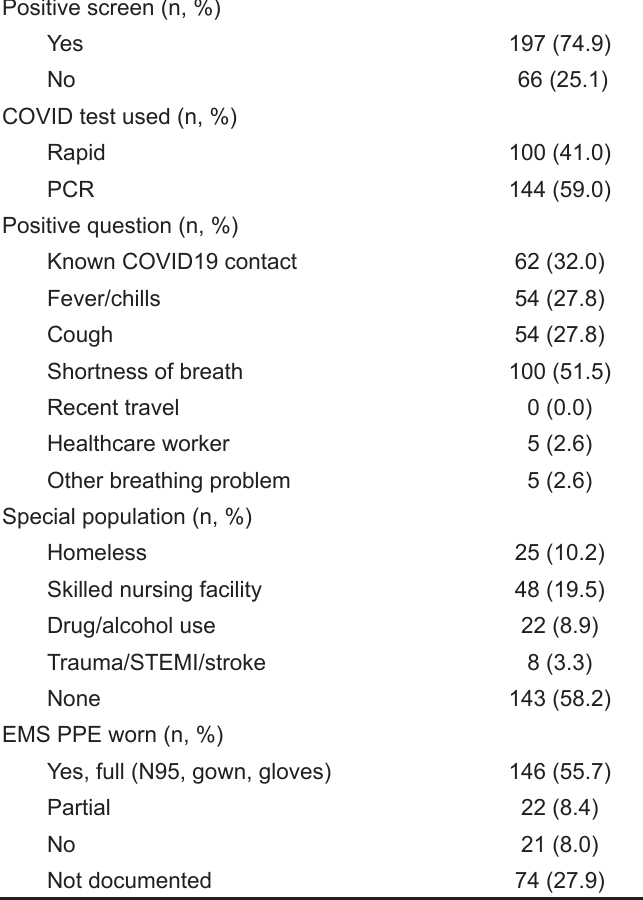
Table 1. Characteristics of coronavirus-2019 positive patients (N =